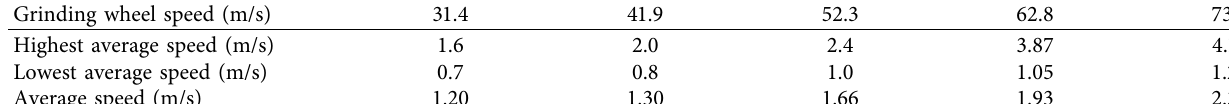
Table 3: The average flying speed of sparks at different speeds.